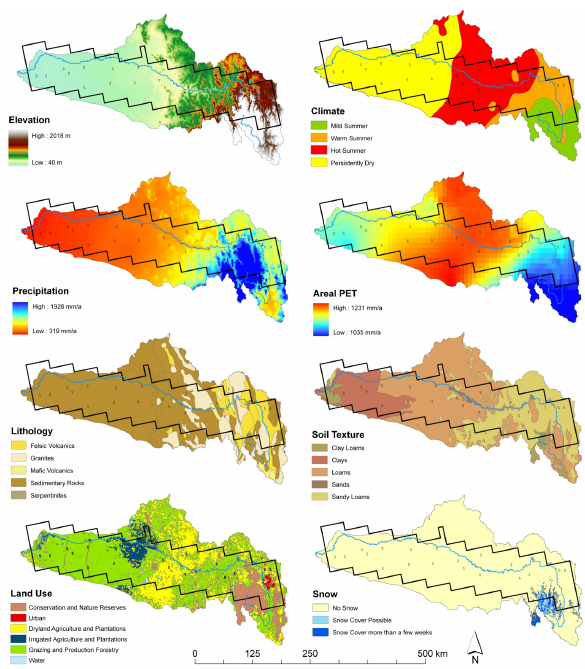
Fig. 2. Overview of the Murrumbidgee River catchment and its climatic, topographic and soil diversity. Overlain is the outline of the AACES study area with the course of the Murrumbidgee River and the location of the 20 focus farms, where the ground sampling activities took place. The spatial data set is publicly available through Australian Bureau of Rural Science (2001, 2006) and Geoscience Australia (2008).